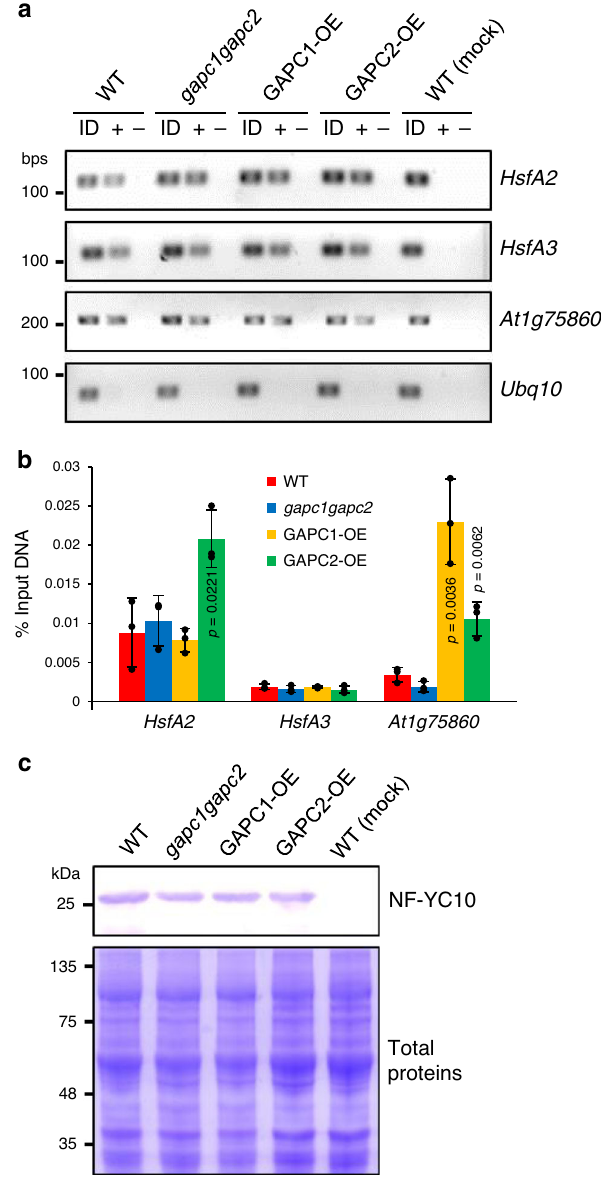
Fig. 9 Effect of GAPC on NF-YC10 binding to its target promoters. a PCR veri fi cation of the precipitated DNA. Chromatin immunoprecipitation (ChIP) was performed using anti-Flag antibody from heat-treated mesophyll protoplasts that were isolated from the GAPC -altered Arabidopsis lines indicated on the top and transfected with 35S:NF-YC10- Flag . Input DNA (ID; see Methods for details) and DNA precipitated with ( + ) or without ( − ) the antibody were used for PCR with primers speci fi c to the promoters of genes indicated on the right. Mock, non-transfected; Ubq10 , ubiquitin10. b Quanti fi cation of the precipitated DNA. Quantitative PCR was performed with the DNA samples obtained from a . Values are average ± S.D. and shown as % of PCR product ampli fi ed from the input DNA. P values indicate signi fi cant difference from WT determined by two- tailed student ’ s t test ( n = 3 independent pools of protoplasts). Black dots represent individual data points. c NF-YC10 protein abundance. After transfection, total proteins were extracted from the protoplasts and immunoblotting was performed with anti-Flag antibody (top). Coomassie blue staining is shown for loading control (bottom).